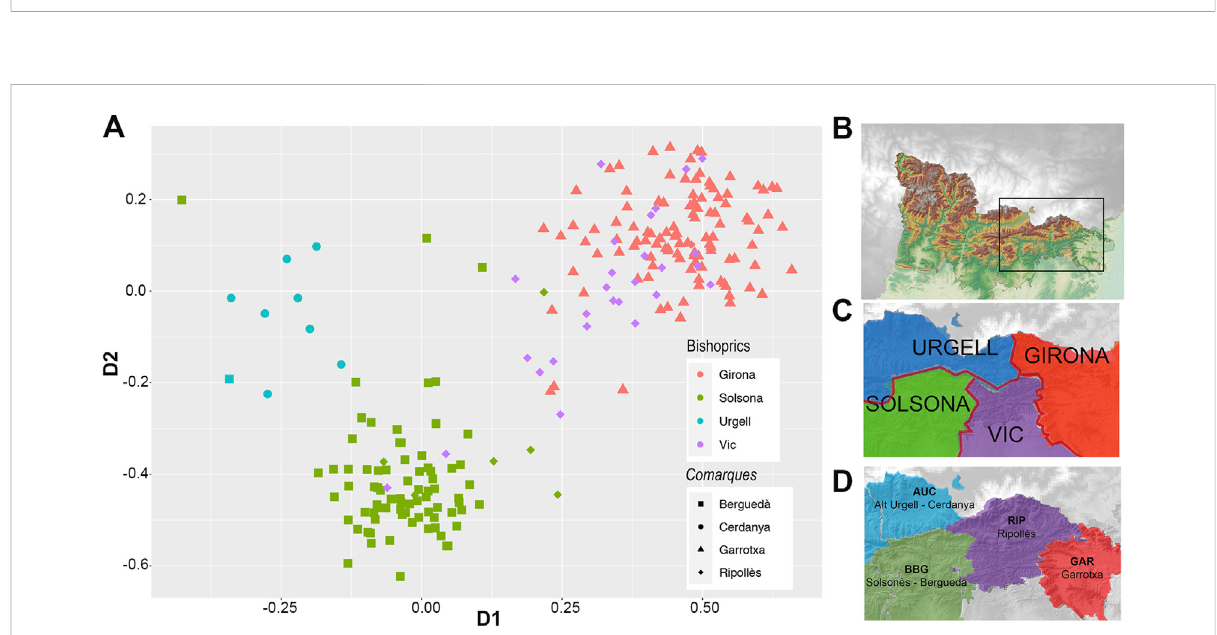
FIGURE 7 (A) FirsttwodimensionsoftheSMACOFanalysisdepictedinFigure6focusingonindividuals( N =230)fromthegeographicregionthatcontains the intersection of four bishoprics. (B) Detailed orography of the focused region. Despite the small distance considered, the in fl uence of bishoprics (C) and comarques (D) is observed. In (A) Colors identify bishoprics (Urgell, blue; Solsona, green; Vic, purple and Girona, red). Shape identify comarques (circles AUC, Alt Urgell-Cerdanya; square BBG, Berguedà-Solsonès; triangles GAR, Garrotxa and diamond RIP, Ripollès). (B) Orography of the detailed region. (C) Colored bishoprics according to clustering, colors as in (A) . (D) Colored comarques according to clustering, (AUC, Alt Urgell-Cerdanya, blue; BBG, Berguedà-Solsonès, green; RIP, Ripollès, purple; GAR, Garrotxa,